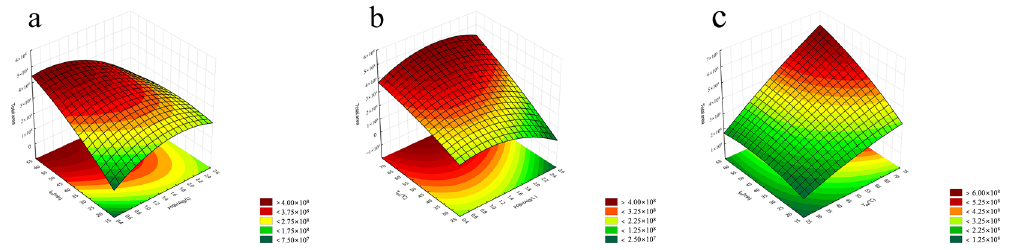
Figure 3. Response surface model for the total area of all volatile compounds vs. ( a ) extraction time (t ex ) and PFBHA content (incubation time = 9 min, temperature = 50 °C), ( b ) extraction temperature (T ex ) and PFBHA content (incubation time = 9 min, extraction time = 40 min), and ( c ) extraction temperature (T ex ) and extraction time (t ex ) (incubation time = 9 min, PFBHA = 1.5 g/L).